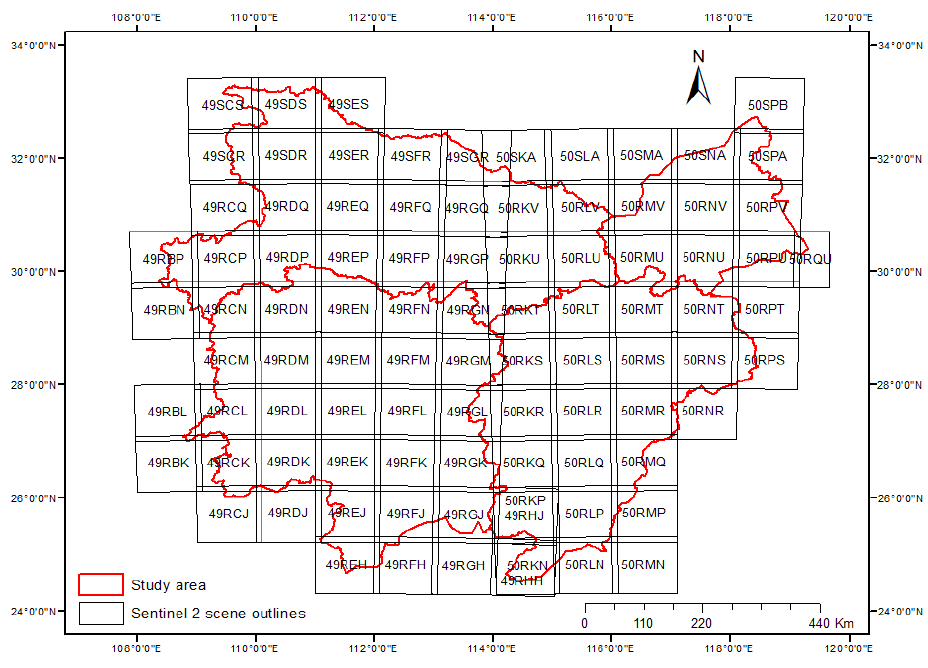
Figure 4. Study area covered by 92 Sentinel-2 scenes.